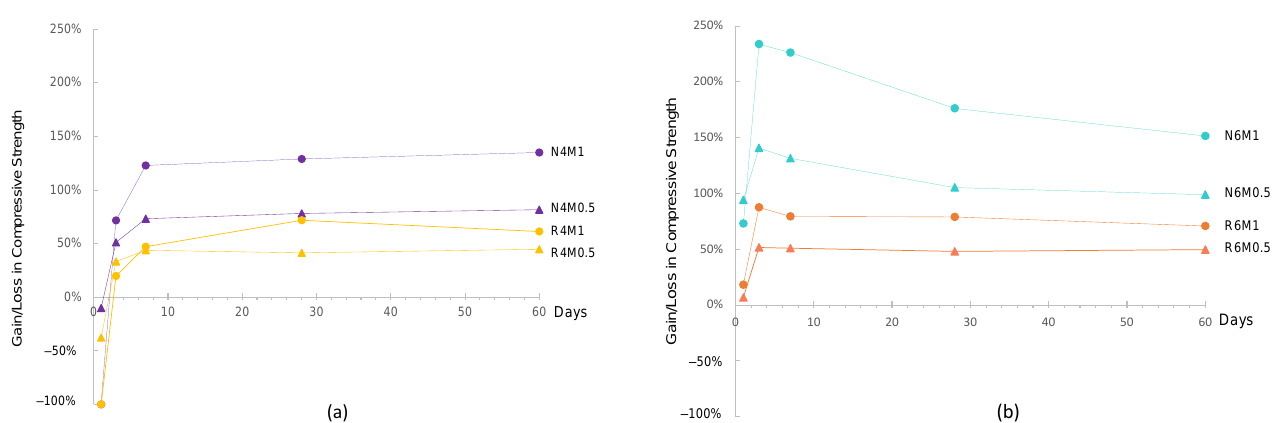
Figure 10. Gain and Strength loss in compressive strength due to the increase in Ms for ( a ) mortars with 4% Na 2 O ( b ) mortars with 6% Na 2 O.